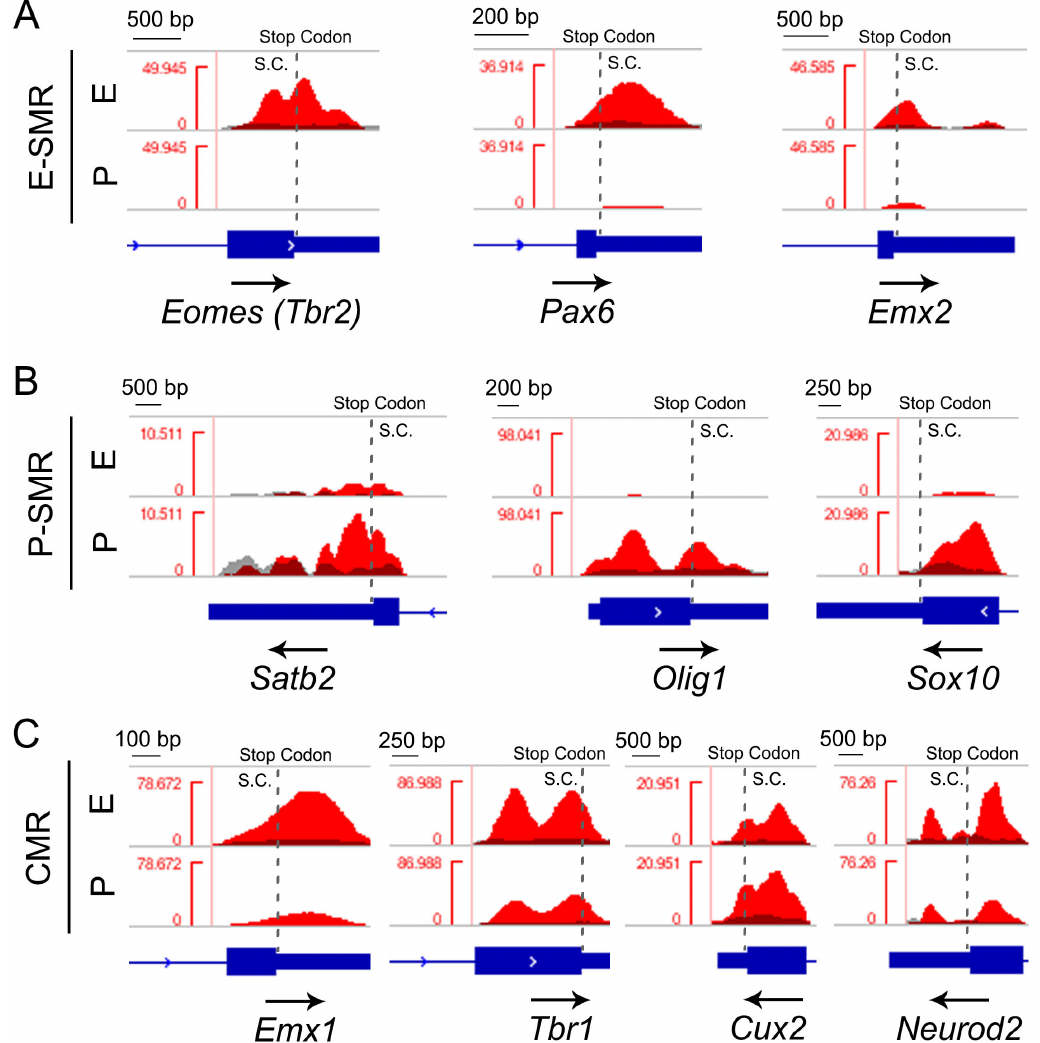
Figure 6. Status of m 6 A-methylation in cortical transcription factors. ( A ) Integrative Genomics Viewer (IGV) analysis of three E-SMRs that function as transcription factors (Pax6, Emx2 and Tbr2). ( B ) IGV analysis of three P-SMRs (Satb2 Olig1 and Sox10). ( C ) IGV analysis of four CMRs encoding transcription factors.